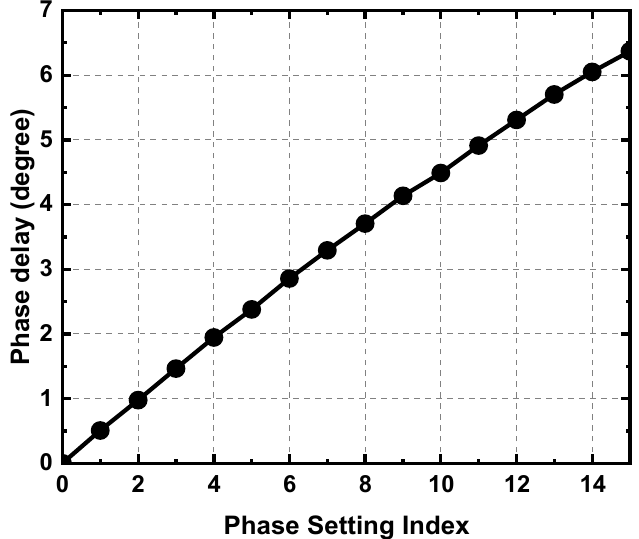
Figure 15. Phase delay with respect to the control bits.